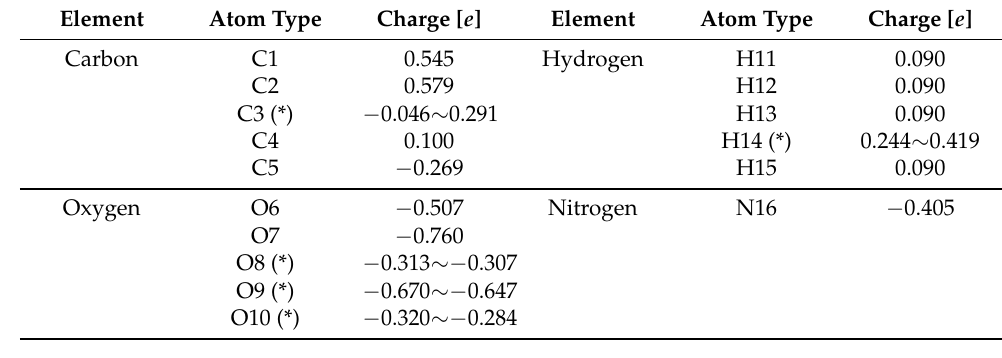
Table 1. Partial charge assigned to each atom type of HA molecule by CGenFF ver. 4.4 [32]. The exact value for atom type with (*) is determined by more detailed local